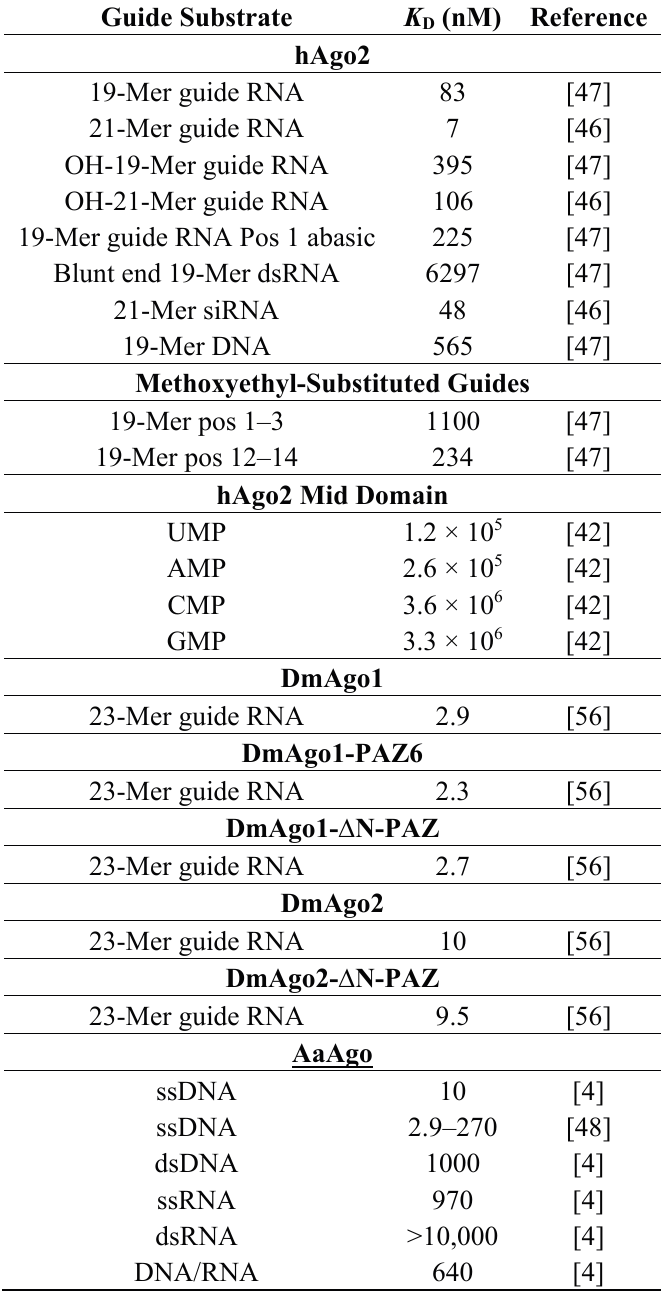
Table 2. Binding affinities of different Ago proteins for various guide